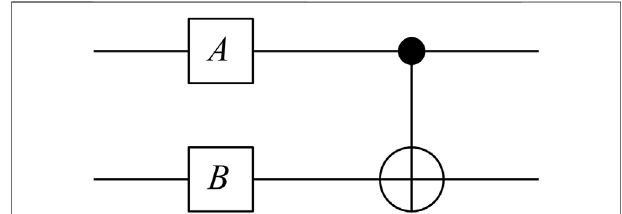
Table 2 . Note that the total probabilities of obtaining B yes or no are the same as in Table 1 for the case where question A is followed by B . Similar calculations can be made with the order of questions reversed, by inverting the C-NOT gate so that the second qubit acts as the control and updating A as R φ and B as R ( θ − φ ) .